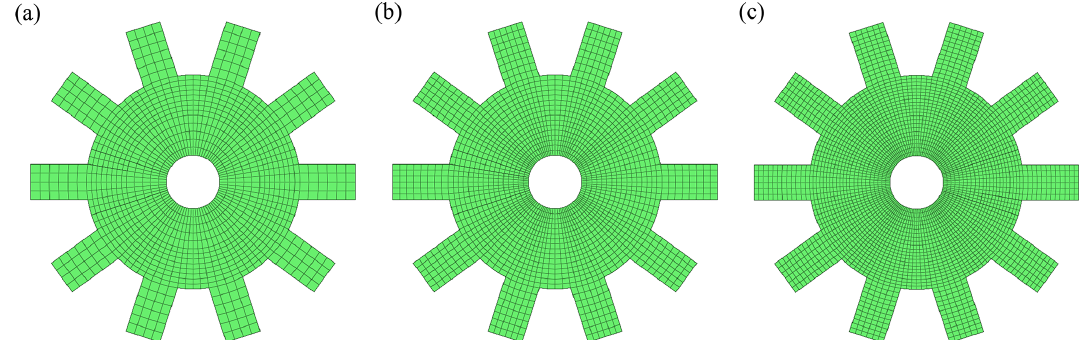
Figure 8. Finite-element models of the disk with a gapless crack: (a) model 1 with 4260 nodes, (b) model 2 with 6780 nodes and (c) model 3 with 14400 nodes.